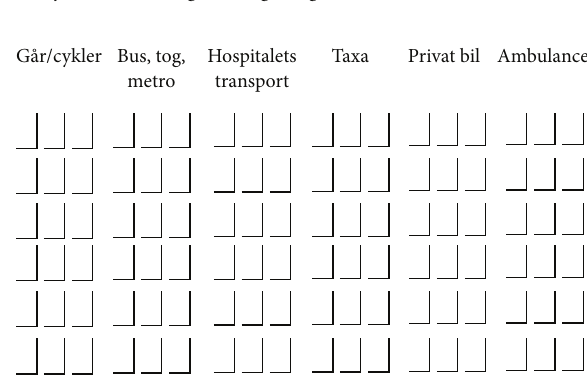
Figure 1: Travel Questionnaire (in